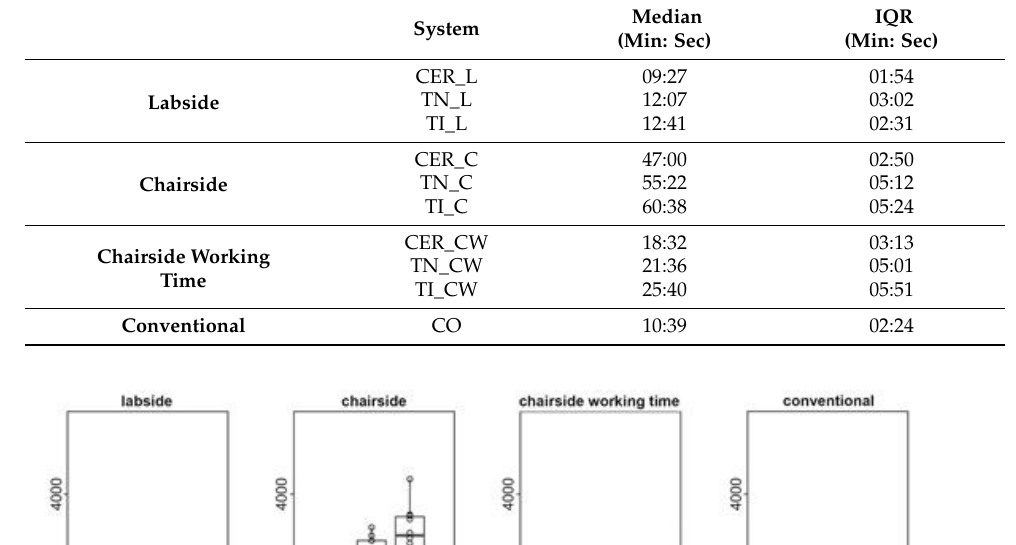
Table 3. Total workflow duration for each test group displayed with median and IQR.